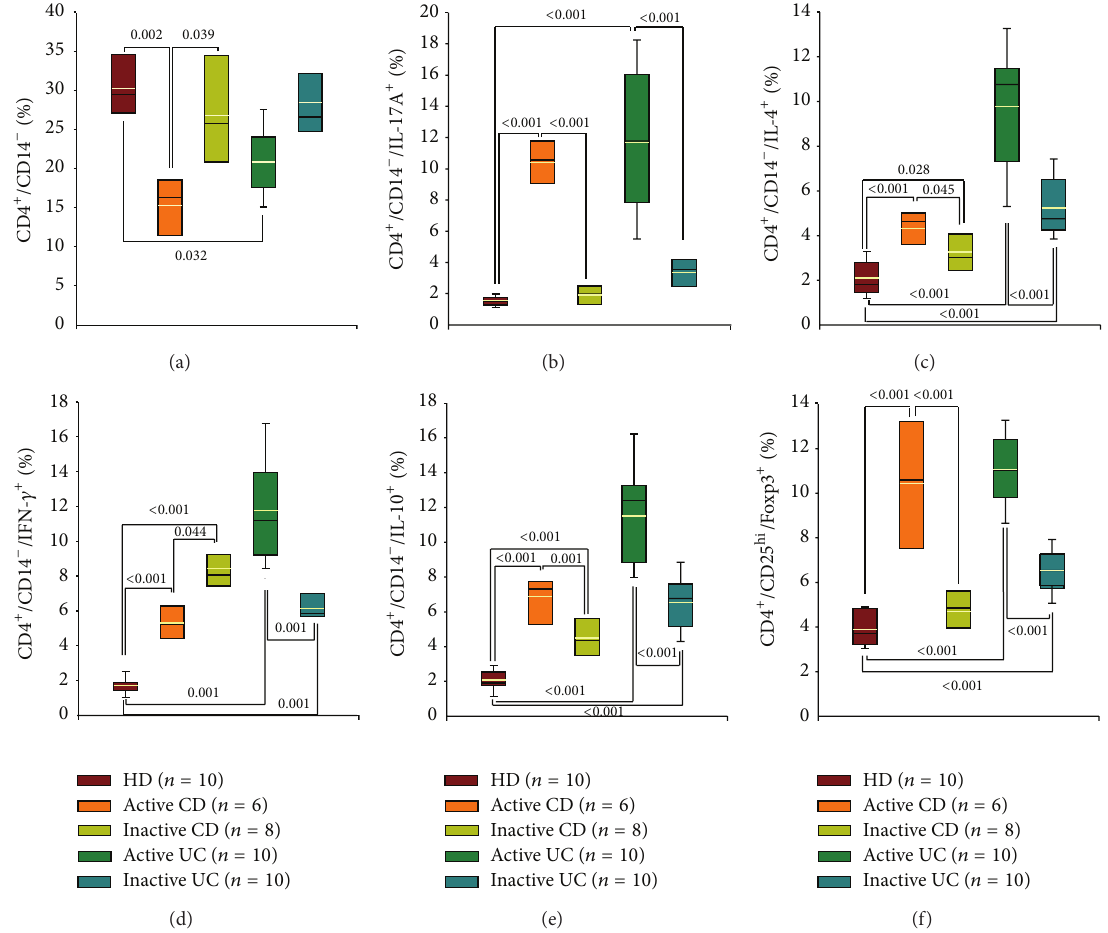
Figure 2: Percentage of cytokine-expressing CD4 + T peripheral cells in IBD (UC and CD) patients. Bar graphs show percentage of (a) CD14 − /CD4 + T cells; (b) CD14 − /CD4 + /IL-17A + ; (c) CD14 − /CD4 + /IL-4 + ; (d) CD14 − /CD4 + /IFN- 𝛾 + ; (e) CD14 − /CD4 + /IL-10 + ; (f) CD4 + /CD 25 hi /Foxp3 + cells. Results are expressed as median (black line), 10th, 25th, 75th, and 90th percentiles. Yellow line represents the